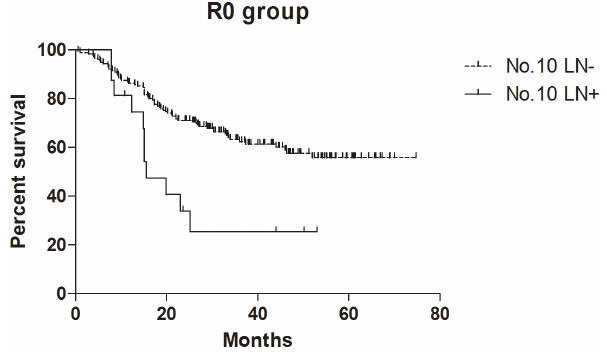
Figure 3. Kaplan-Meier survival analysis of No.10 LNs for R0 group in all